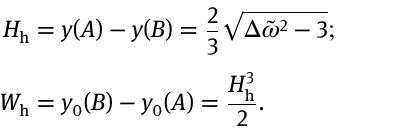
Figure 2: Bistability in a single-mode nonlinear optical resonator. (a) Dimensionless mode intensity y = 𝛼 | a | 2 ∕ 𝛾 as a function of dimensionless pumping intensity y parameters Δ ̃𝜔 = 1 , 3 , 5 and relative nonlinear coefficient b = 0.05. Gray region corresponds to hysteresis area with height H W h . (b) The map of the heating efficiency as the function of the detuning and the pump intensity for the upper branch of the solution b = 0.05. The bistability region is shown with a hatch. The critical coupling line (maximal heating efficiency) is denoted with the dashed line. (c) The evolution of the bistability regions with the variation of relative nonlinear coefficient b